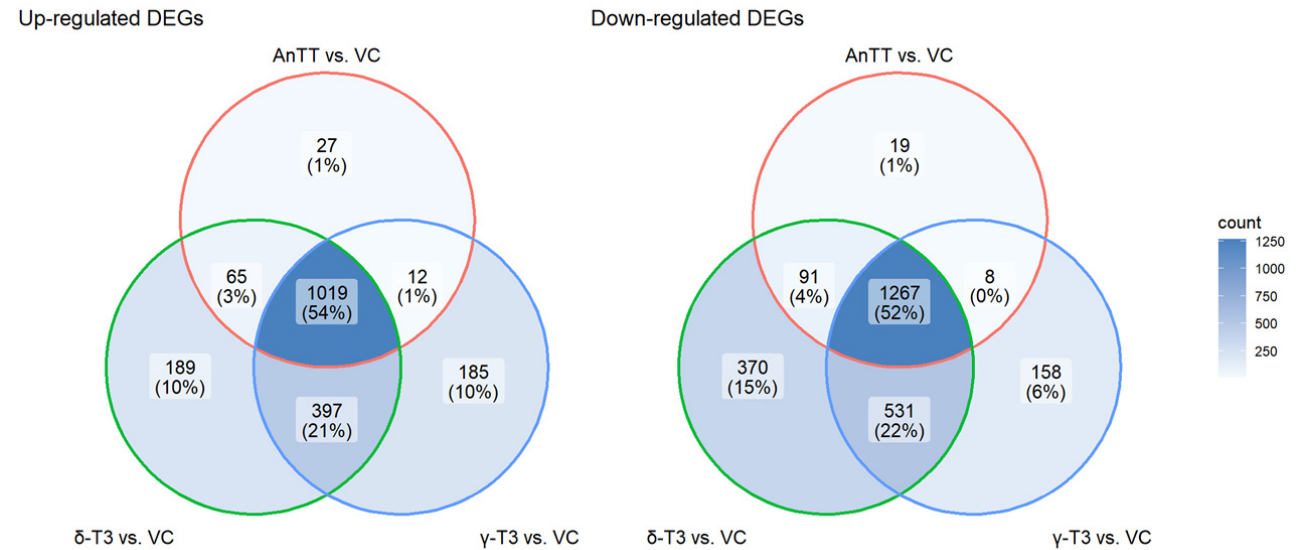
Figure 8. Venn Diagrams show the numbers of the up- and down-regulated differential expressed genes (DEGs) among the pairwise comparisons of different tocotrienol treatments (namely annatto tocotrienol (AnTT), δ -tocotrienol ( δ -T3) and γ -tocotrienol ( γ -T3)) and vehicle control (VC) group.